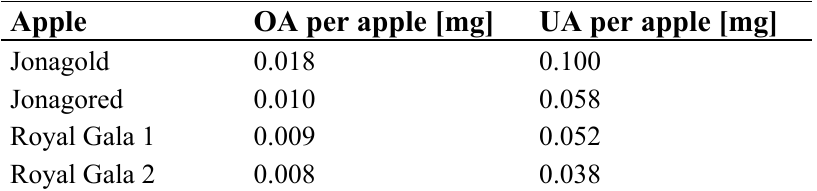
Table 3. Triterpene distribution within apples.